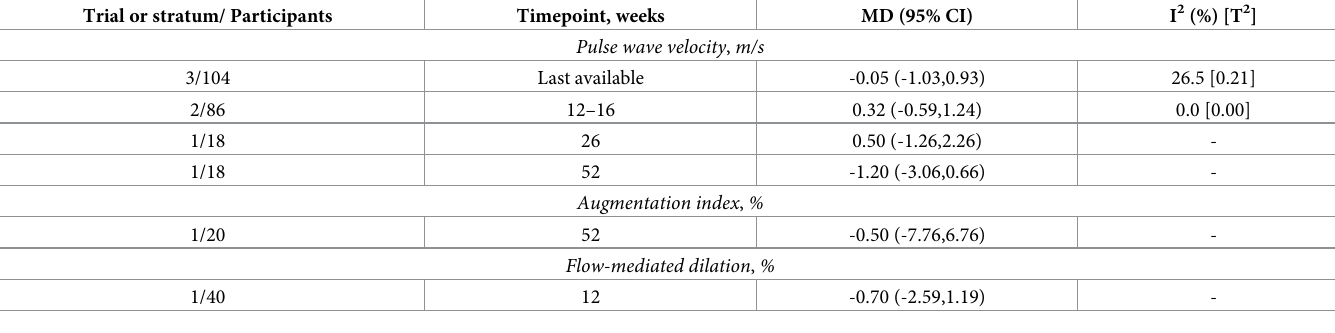
Table 5. Meta-analysis–Exercise versus no intervention on other vascular